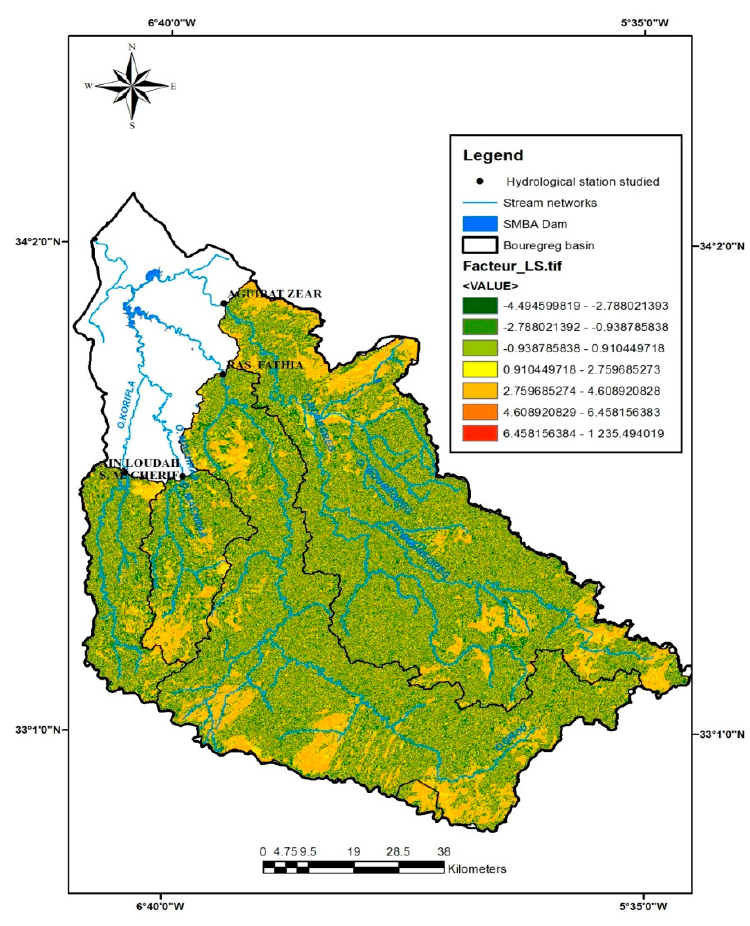
Figure 7. LS factor of the Bouregreg basin at the four hydrological stations.